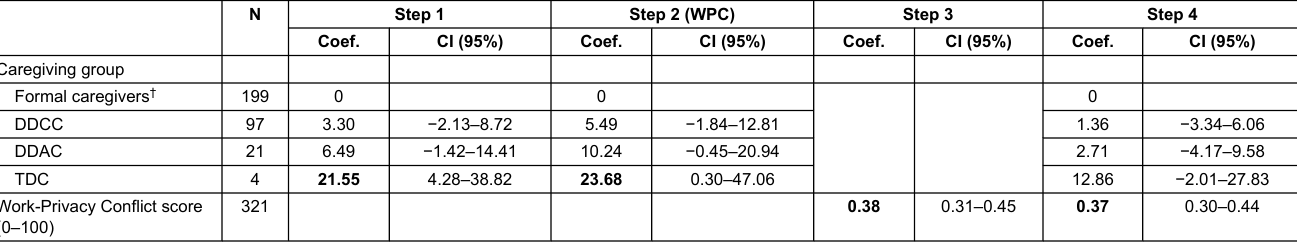
Table 5: Burnout risk for caregiving groups of other health professionals: four-step mediation analyses*. Step 1 Step 2 (WPC) Step 3 Step 4N Coef. CI (95%) Coef. CI (95%) Coef.